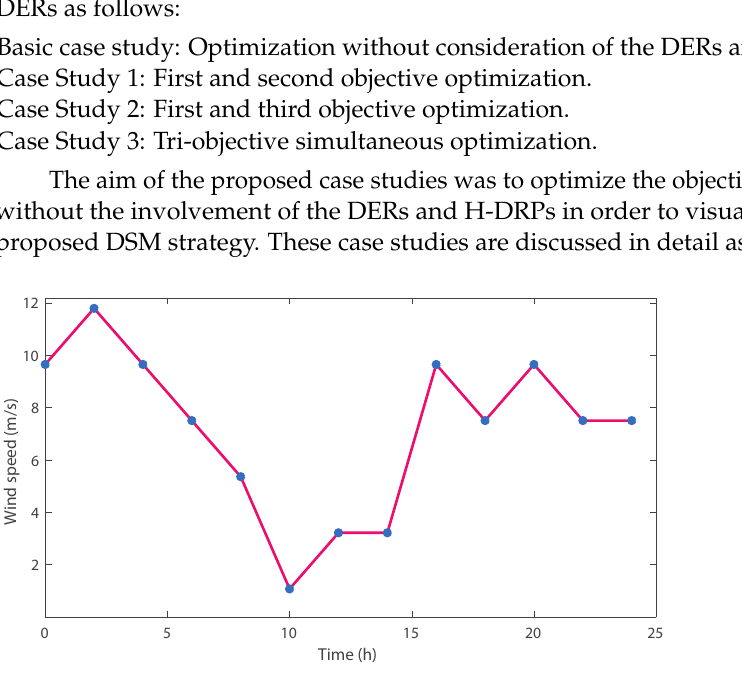
Figure 3. Computational time and number of iterations of the MOGA for each case